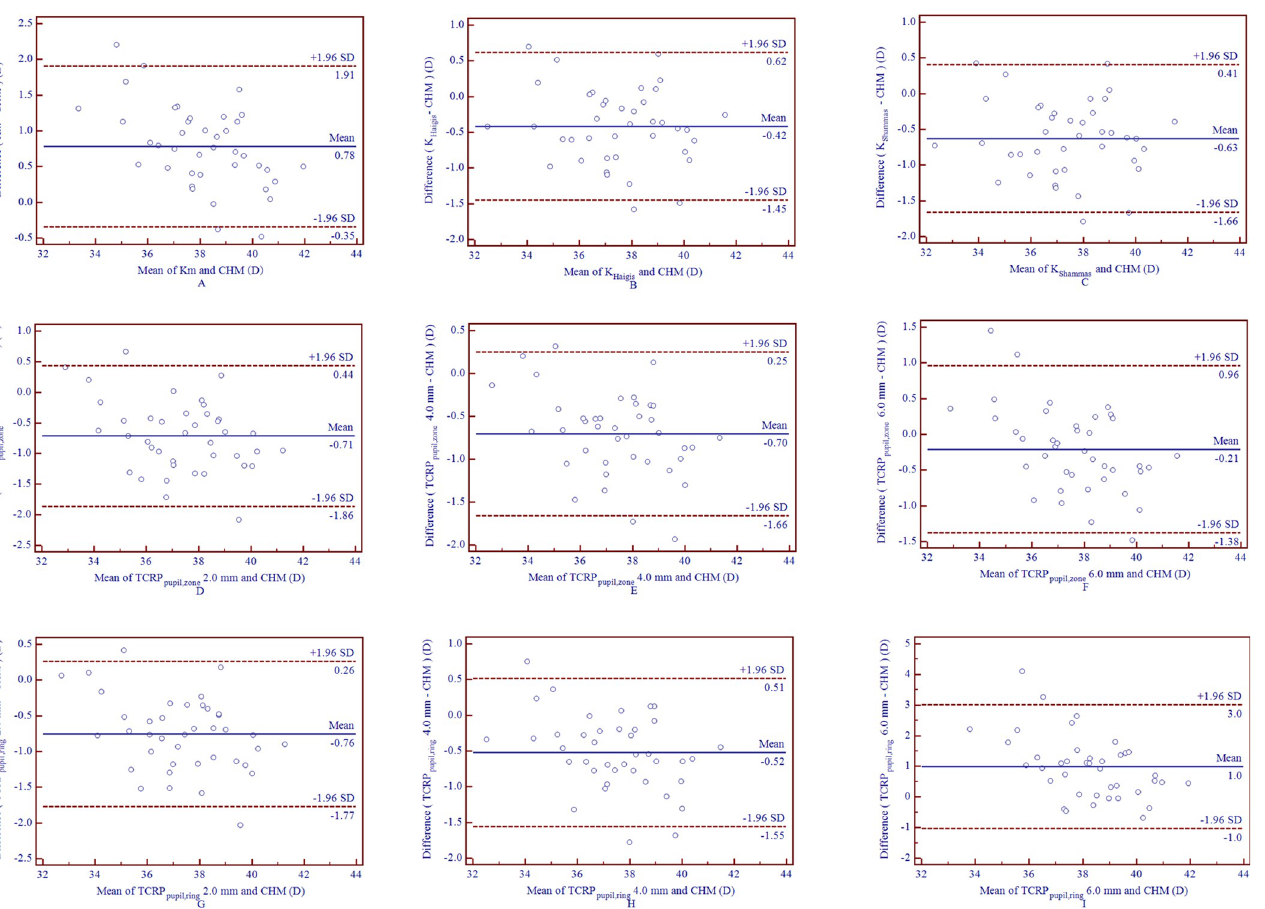
Fig 1. Bland-Altman plots of agreement of various corneal power measurements (Km, keratometric values derived from the 2 formulas and a series of pupil-centered TCRP) compared with the CHM value in eyes following SMILE surgery (A-I represent Km, K Haigis , K Shammas ,2.0 mm, 4.0 mm and 6.0 mm TCRP pupil,zone , 2.0 mm, 4.0 mm and 6 mm TCRP pupil,ring , respectively). The solid line represents the mean difference (bias). The upper and lower lines represent the 95% LOA (the 95% LOA are shown with the dashed lines.) (CHM = clinical history method; Km = mean keratometry; K Haigis /K Shammas represent keratometric values calculated from the Haigis method and the Shammas method; LOA = limits of agreement; SMILE = small incision lenticule extraction; TCRP = total corneal refractive power; TCRP pupil,zone /TCRP pupil,ring represent TCRP within a diameter of a zone or ring centered on the pupil axis).